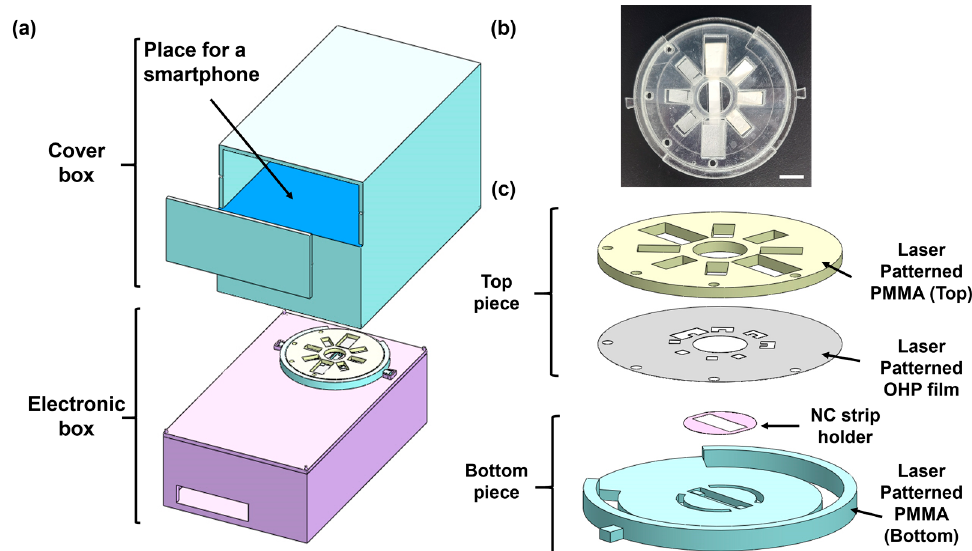
Figure 1. ( a ) Schematic of the operating platform showing the cover box and the electronic box with the rotary device placed inside. ( b ) Photo of the rotary device with the NC membrane, glass fiber pads, and absorbent pads installed in it. Scale bar = 1 cm. ( c ) Exploded view of the rotary device showing each layer and its components.